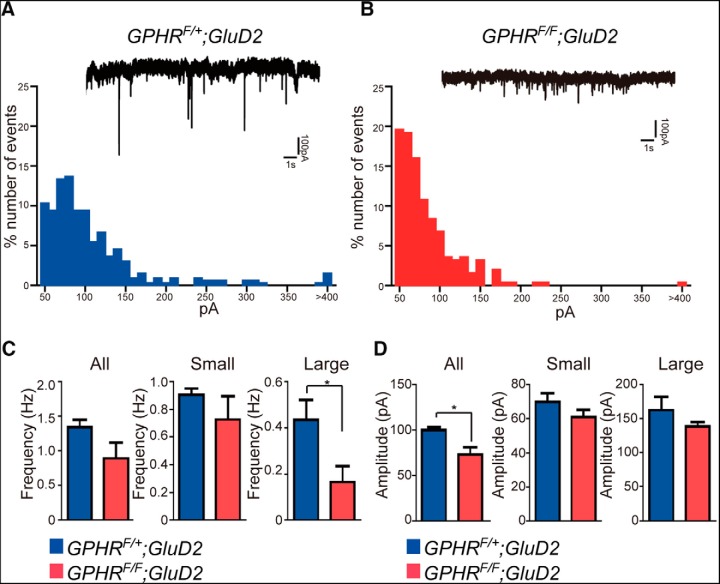
The alteration in GABAergic transmission in PCs from GPHRF/F;GluD2-Cre mice. Histogram showing the distribution of mIPSC amplitude in GPHRF/+;GluD2-Cre mice (A) and GPHRF/F;GluD2-Cre mice (B) PCs. ACSF containing 1 µM TTX and 10 µM CNQX was used. Insets are representative mIPSC traces. Holding potential (Vh) = −70 mV. C, The bar graphs show the average frequency of mIPSC for all, small (<100 pA), and large (>100 pA) events in GPHRF/+;GluD2-Cre mice (n = 4) and GPHRF/F;GluD2-Cre mice (n = 4). Data are presented as the mean ± SEM; *p < 0.05 (unpaired Student’s t test). D, The bar graphs show the average amplitude of mIPSC for all, small (<100 pA), and large (>100 pA) events in GPHRF/+;GluD2-Cre mice (n = 4) and GPHRF/F;GluD2-Cre mice (n = 4). Data are presented as the mean ± SEM; *p < 0.05 (unpaired Student’s t test).